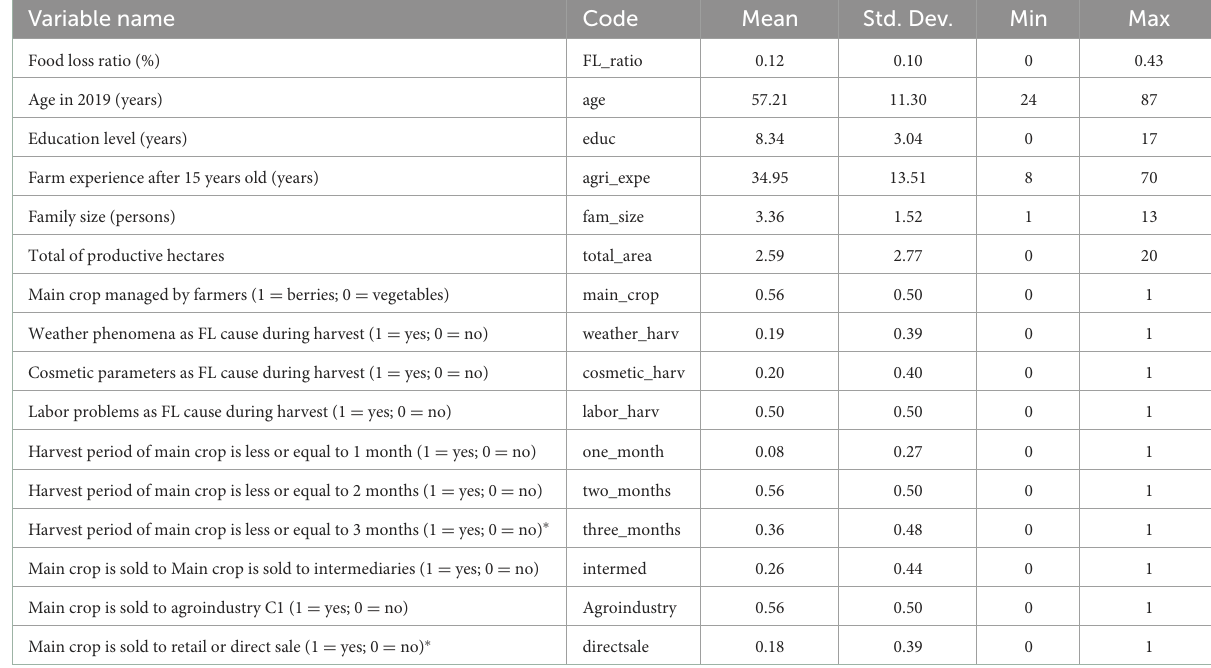
TABLE 1 Descriptive statistics of the sample of farmers surveyed in two agricultural regions of Chile during June and September of 2020. Variable name